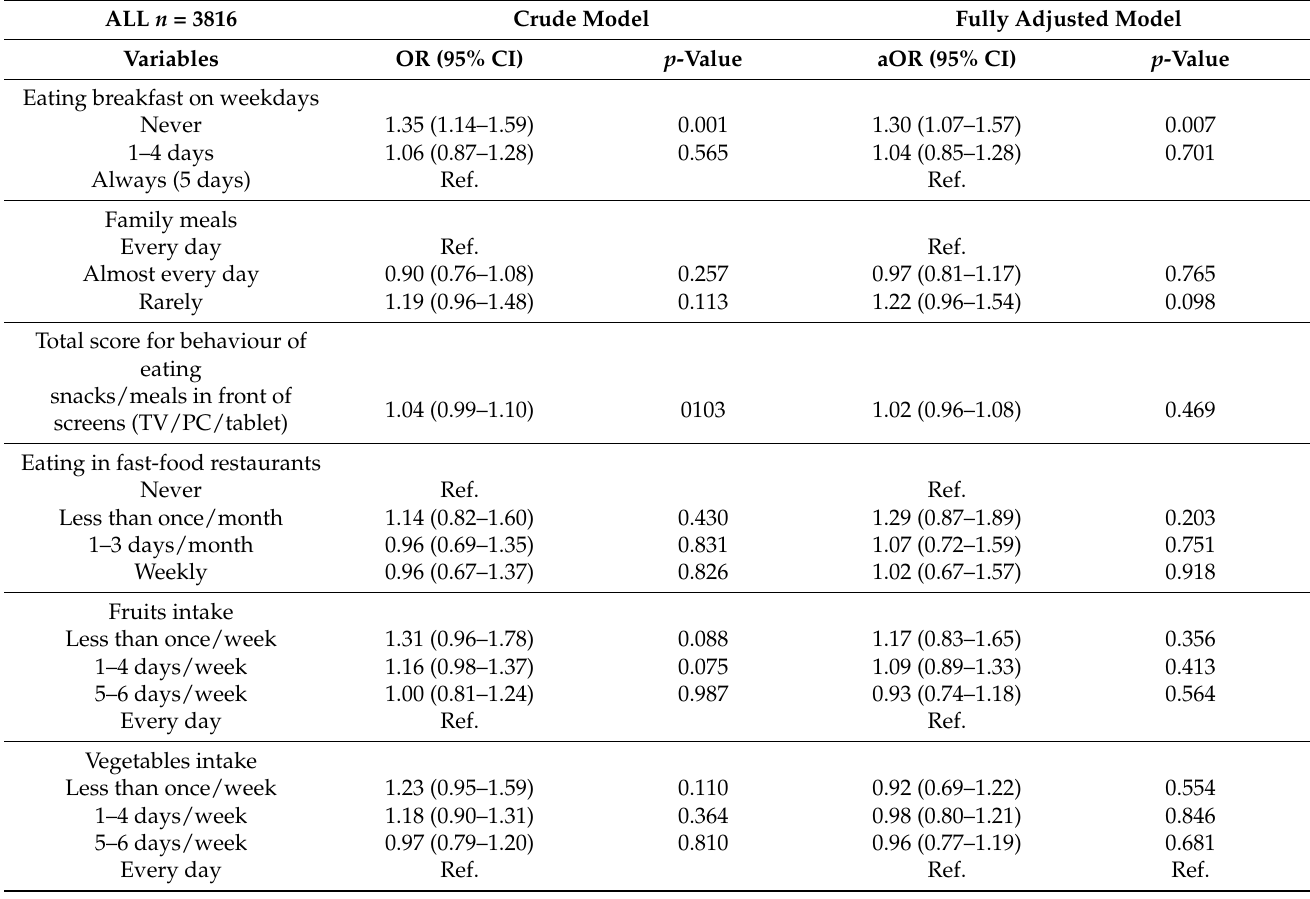
Table 3. Crude and adjusted Odds ratios (aOR) and associated 95% confidence intervals (CI) from logistic regression models exploring the association of Overweight with diet-related behaviours and habits among 3816 participants in the 2018 Greek arm of the HBSC study